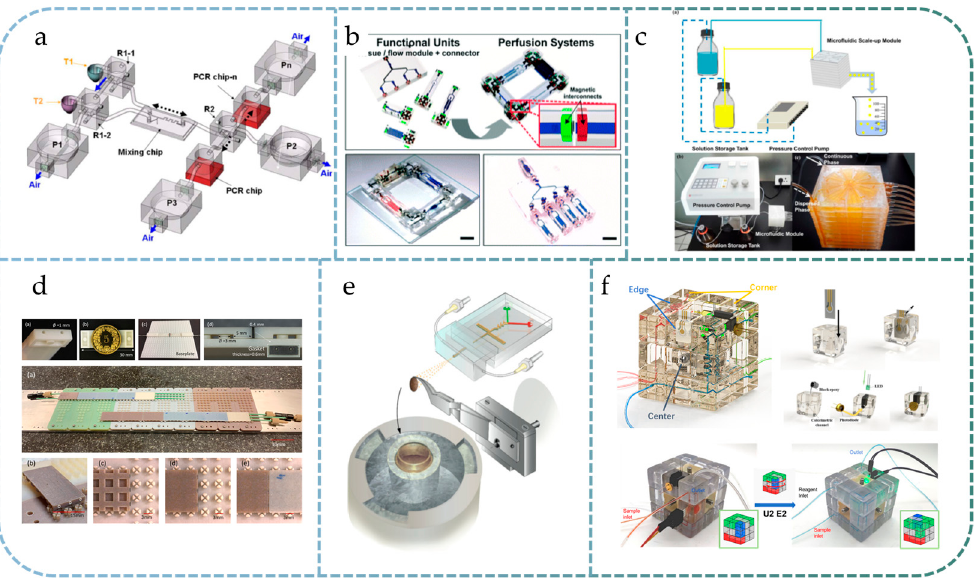
Figure 4. Photographs of modular microfluidic systems for different application scenarios: ( a ) modular Figure microfluidic design for on-chip PCR system that reduces the risk of a single point of failure, reprinted with permission from Ref. [79]. 2011, Springer Nature; ( b ) modular building blocks to study the inter- actions between multiple organs-on-chips, Reprinted with permissions from Ref. [29]. 2019, Royal Soci- ety of Chemistry.; ( c ) modular microfluidics for highly parallel reactions of microsphere synthesis by stacking 10 identical modules. Reprinted with permission from Ref. [83]. 2018, IOP Publishing; ( d ) modular microfluidics for unlimited extension of cooling substrates used in high-energy physics de- tectors. Reprinted with permission from Ref. [86] under Creative Commons CC-CY license; ( e ) mod- ular design of a microfluidic system for parameter control in cryo-EM sample preparation, Re- printed from Ref. [89] under Creative Commons CC-CY license; ( f ) Rubik’s cube-like